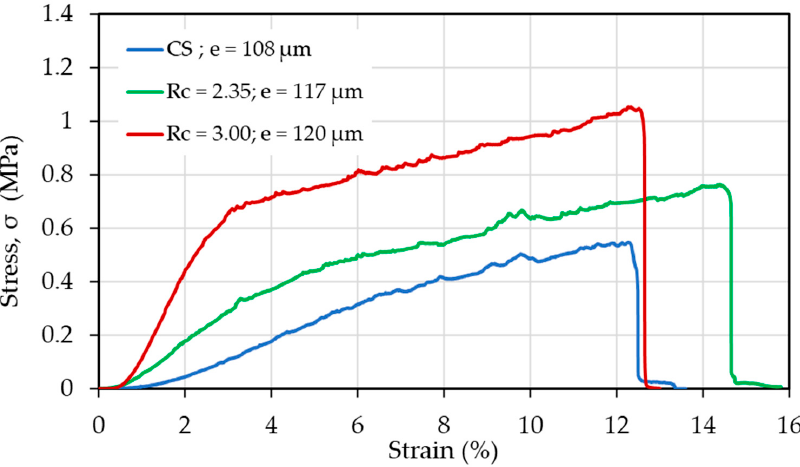
Figure 3. Mechanical behavior of as-spun chitosan and PEC fiber samples in a dried